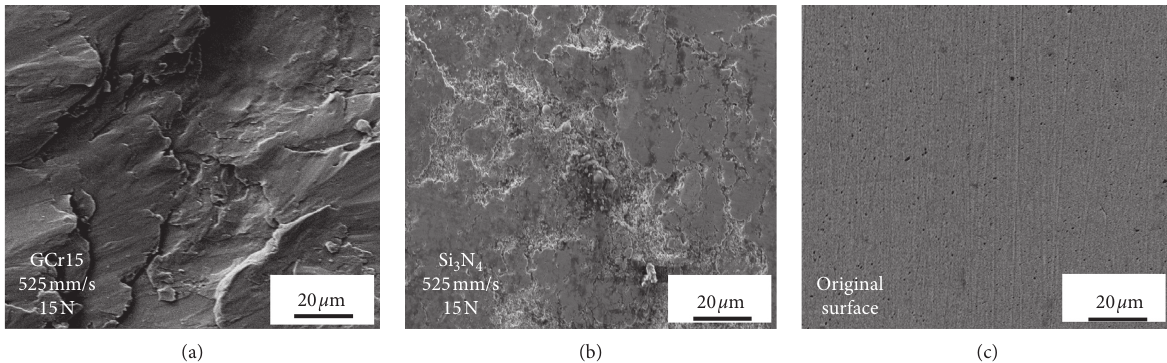
Figure 8: (a, b) SEM images of wear marks of Inconel 625 after friction at room temperature and sliding rate of 525mm/s; (c) typical surface morphology of the original